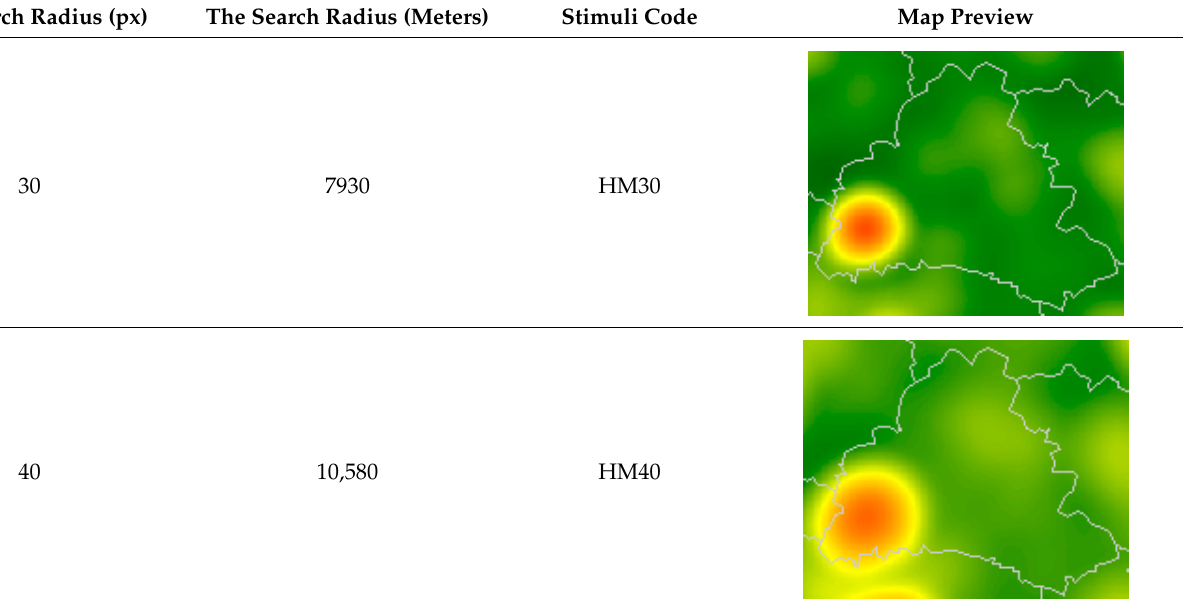
Table 2. Content of tasks, type of tasks, and answer types.